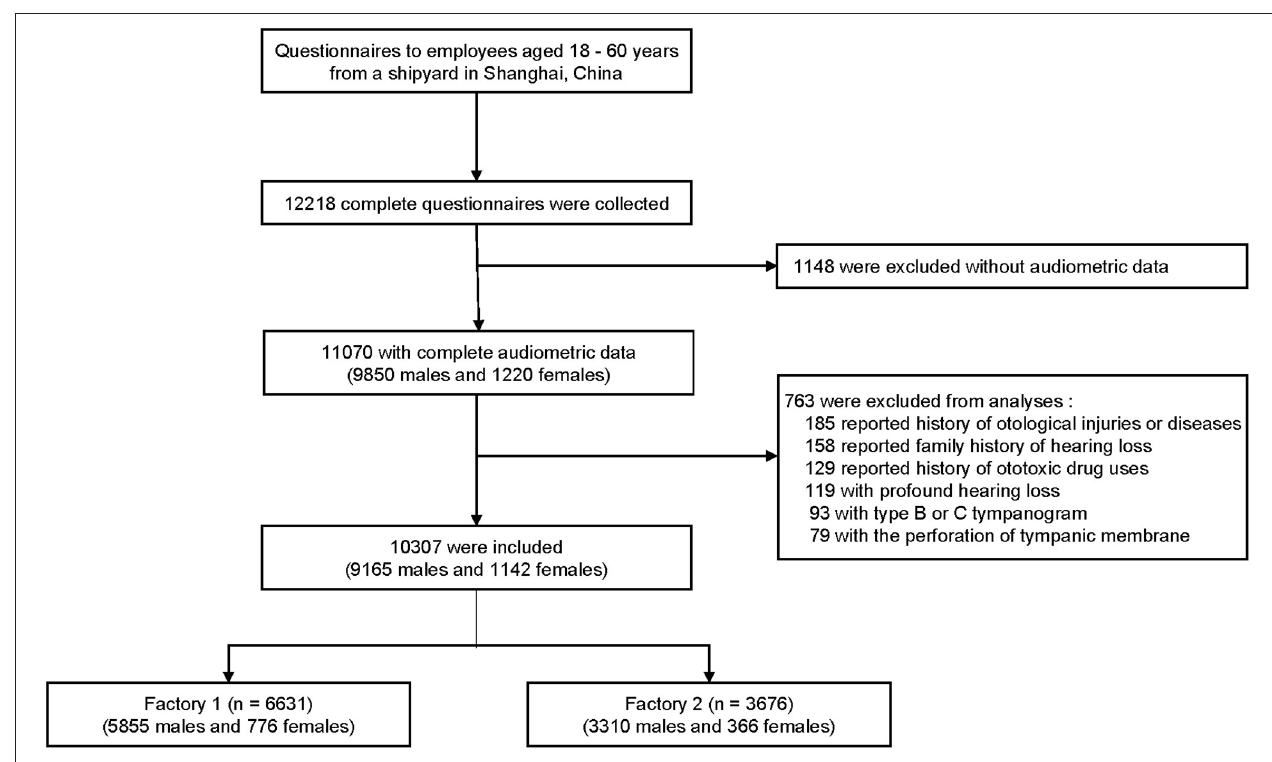
FIGURE 1 | Flowchart of this cross-sectional